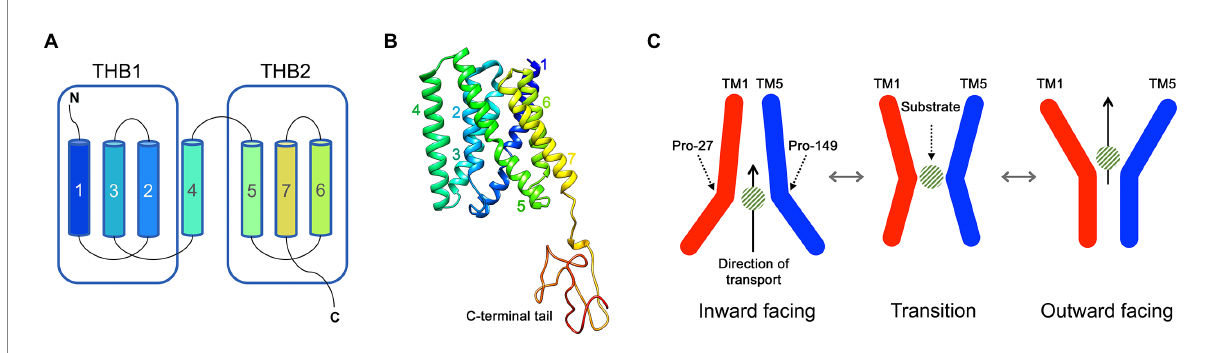
FIGURE 1 The structure and transport mechanism of SWEET proteins. (A) A schematic of a typical eukaryotic SWEET showing the seven transmembrane (TM) helices that are organised into two TM helix bundles (THB). (B) The crystal structure of AtSWEET13 with each TM helix numbered. (C) The proposed transport mechanism of SWEET proteins. Two Pro residues (such as Pro27 and Pro149, numbered according to AtSWEET13) act as molecular hinges allowing the opening and closing of intra- and extracellular cavities for the translocation of a sugar substrate across a